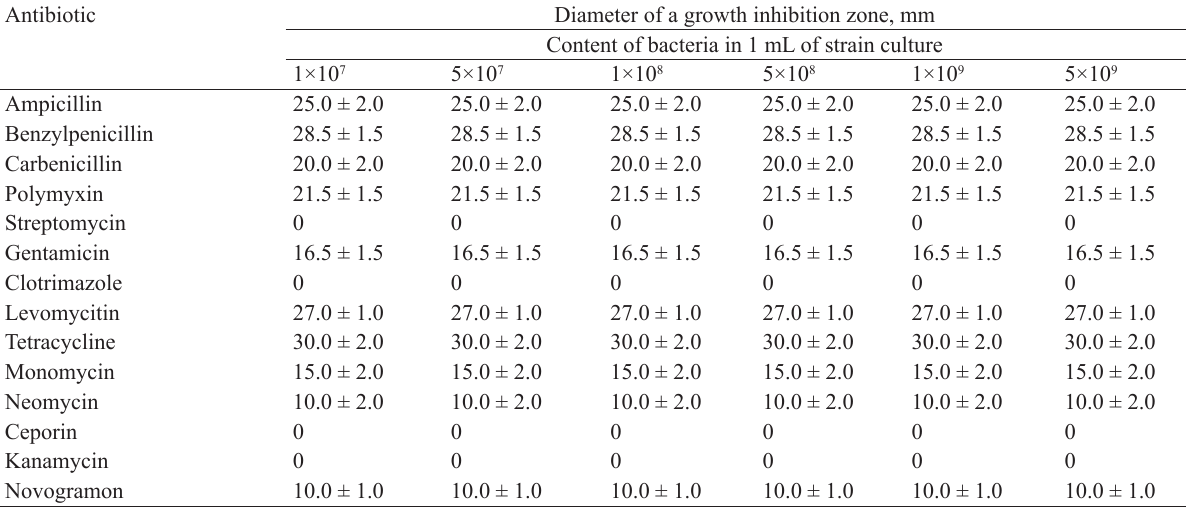
Table 4 Antibiotic resistance of Lactobacillus plantarum isolate Antibiotic Diameter of a growth inhibition zone, mm Content of bacteria in 1 mL of strain